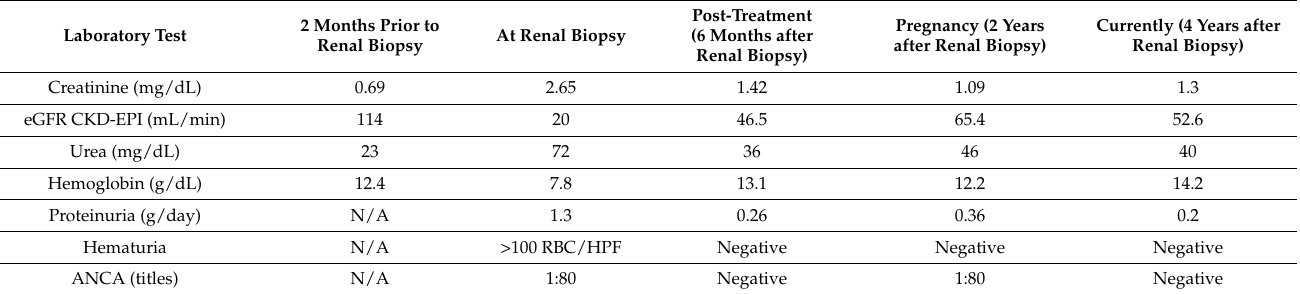
Table 1. Laboratory tests along clinical